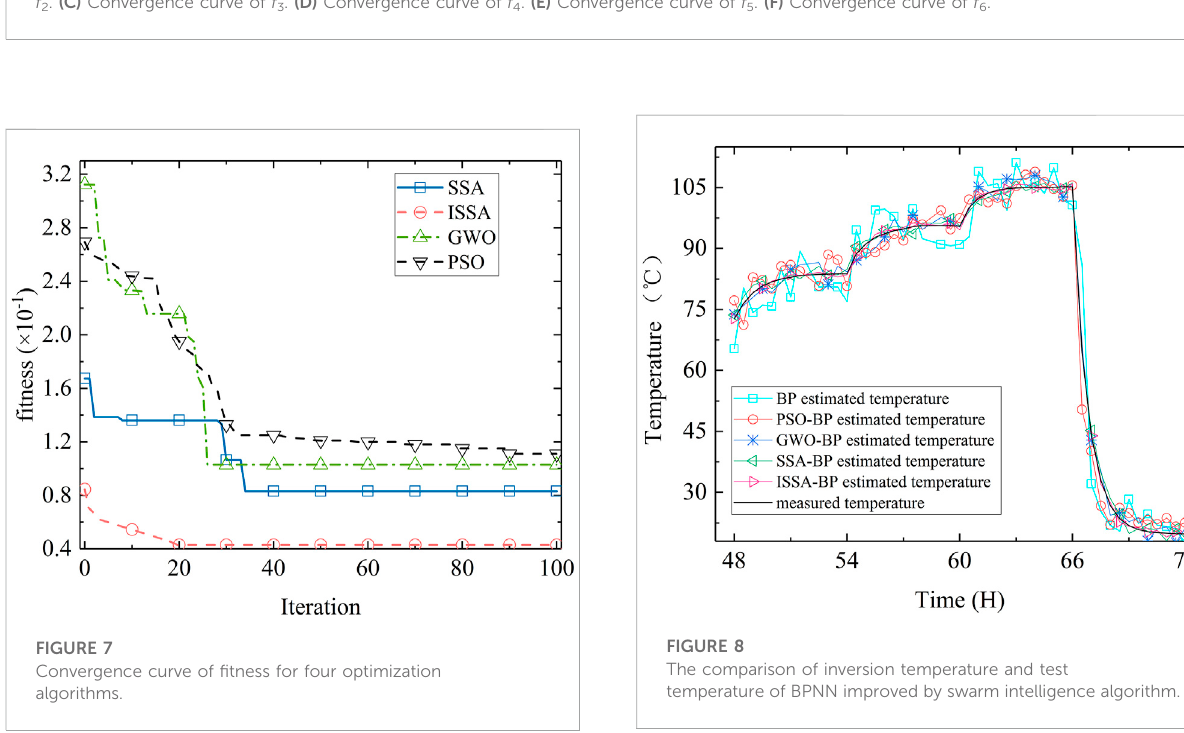
FIGURE 6 Convergence curve of fi tness for four optimization algorithms on Benchmark function. (A) Convergence curve of f 1 . (B) Convergence curve of f